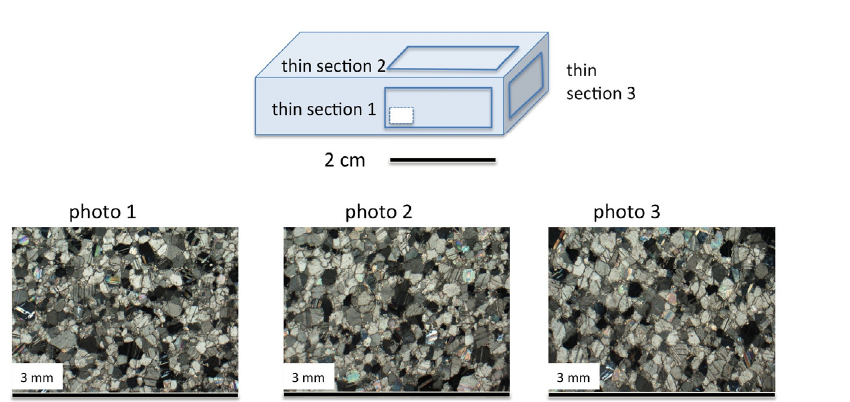
Figure 2: View of the three orthogonal thin sections being analysed